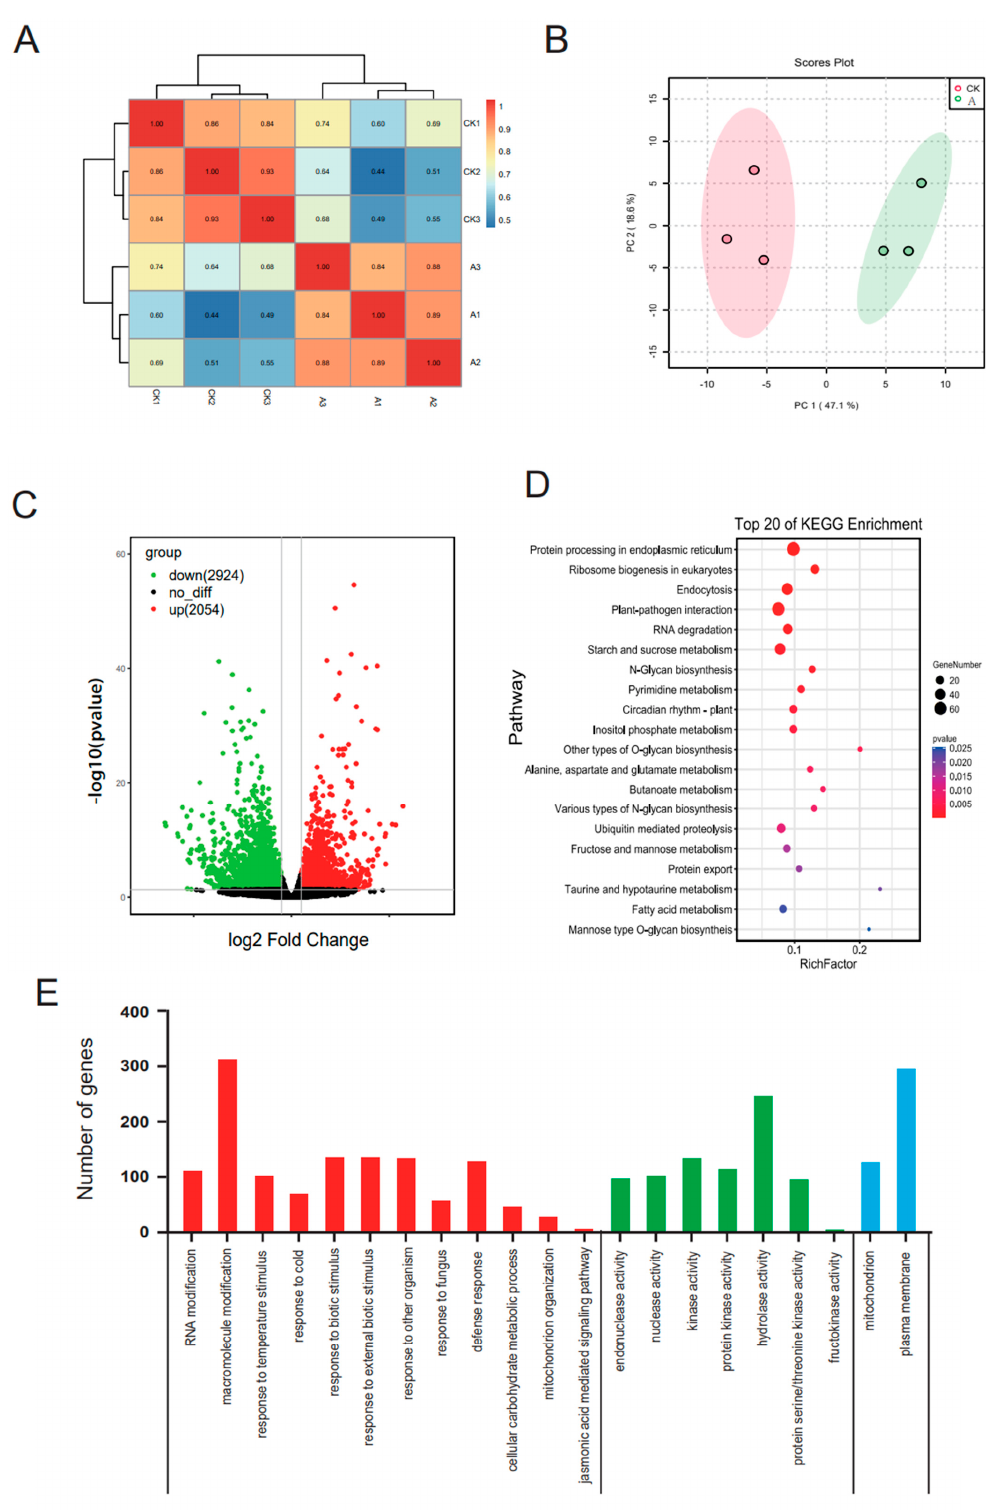
Figure 2. Data analysis of the transcriptome in Mikania micrantha . ( A ) Pearson correlations between CK (control) and A (treatment) replicates. ( B ) Volcano map of differential metabolites. Red plots indicate the up ‐ regulated metabolites; Green plots indicate the down ‐ regulated metabolites; Black plots indicate no significant difference. ( C ) Principle component analysis of expressed genes based on the gene expression profiles. ( D ) KEGG enrichment pathway of up ‐ regulated genes. ( E ) GO clas ‐ sification of up ‐ regulated genes. The significantly different metabolites are listed in Table 1 according to the criteria fold change ≥ 2 or ≤ 0.5, p < 0.05 (T ‐ test) and VIP ≥ 1. Metabolites (61 downregulated and 13 up ‐ regulated) significantly changed upon P. spegazzinii exposure (Table 1). Among these metabolites, carbohydrates, phenylpropanoids, fatty acids, plant hormones, and the levels of most organic acids and their derivatives, flavonoids, and some amino acids and their derivatives decreased (Table 1). The content of some amino acids and flavonoids increased (Table 1). Table 1. Significantly altered metabolites in M. micrantha leaves under stress. Type